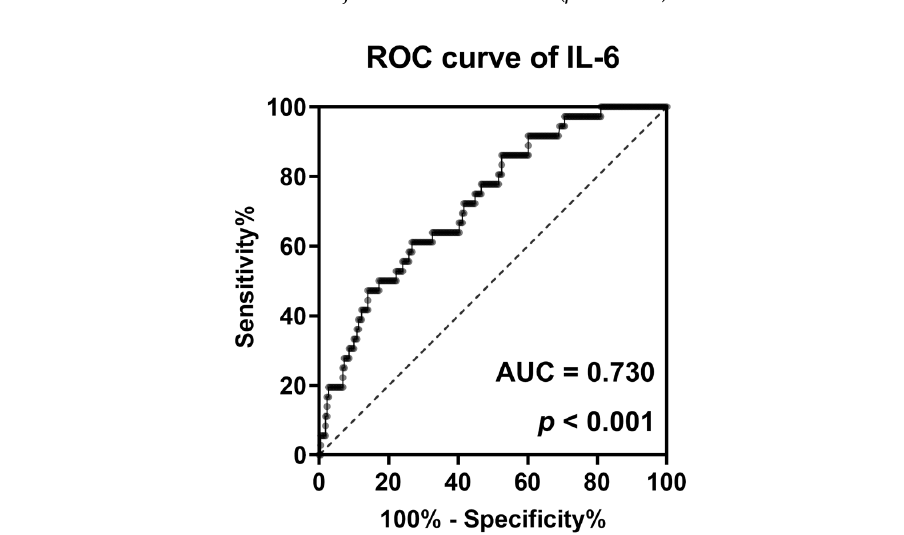
Figure 4. A covariable-adjusted ROC curve for the evaluation of the discriminative power of plasma